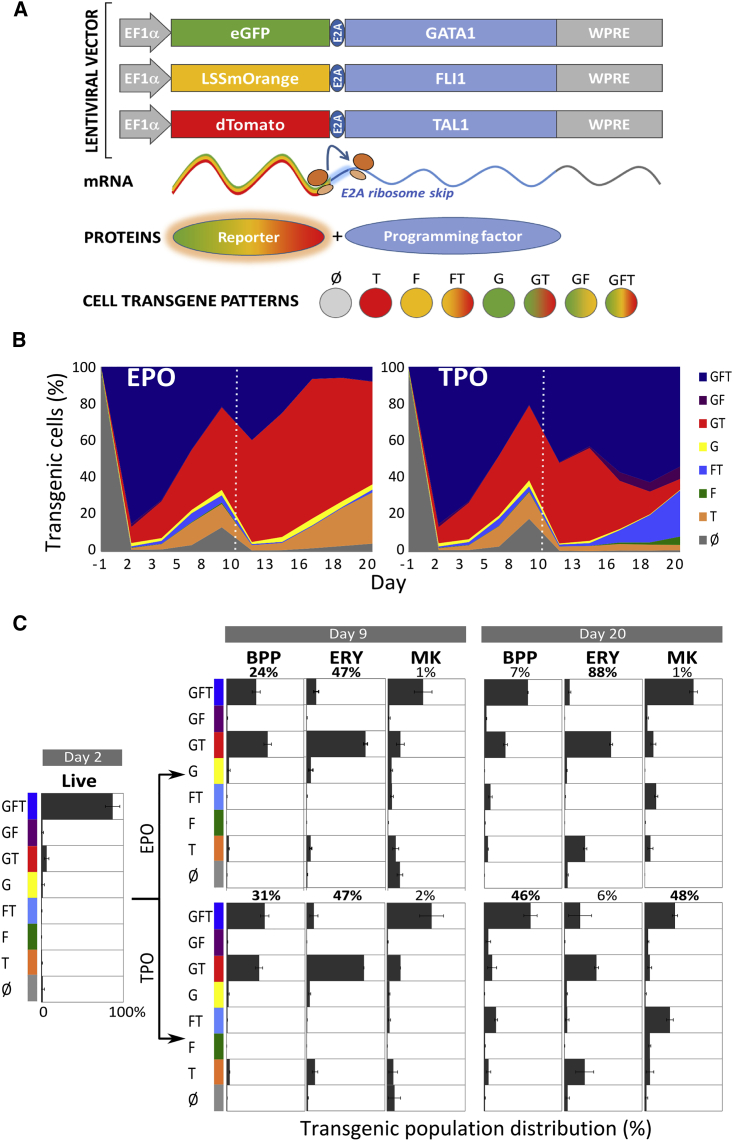
Bipotent Progenitors, Megakaryocytes, and Erythroblasts Have Consistent Transgene Expression Patterns Regardless of the Culture CytokinesForward programming was performed using rainbow vectors and transgene expression patterns were identified by flow cytometry.(A) Schematic representation of the rainbow vector system. The open reading frame (GATA1, FLI1, and TAL1) for each transcription factor was cloned downstream of a different reporter gene (eGFP, LSSmOrange, and dTomato, respectively) separated by a self-cleaving E2A sequence (see vector maps in Supplemental Experimental Procedures). This ensures the production of the reporter, and programming transcription factor proteins are proportional since they are derived from a single mRNA. The fluorescence directly reports the programming factor expression in every single cell (see Figure S5).(B) Representative depiction of the dynamic evolution of transgene expression patterns in viable cells from the hPSC stage (day −1) until day 20 post-transduction in EPO (left) and TPO (right) conditions. Cells were gated according to expression of G(ATA1), F(LI1), and T(AL1).(C) FoP cell surface markers expression and transgene expression were analyzed by flow cytometry at day 2 (left column), day 9 (middle column), and day 20 (right column) post-transduction (EPO cultures in the top panel and TPO cultures in the bottom panel). Cells have been divided according to expression of differentiation markers (CD235a and CD41a) into BPP (CD41a+ CD235a+), ERY (CD235a+ CD41a−), and MK (CD235a− CD41a+). Transgene expression patterns (G and/or F and/or T) are shown as mean% ± SEM (n = 3).